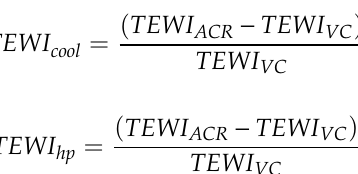
Figure 4. Coefficients of performance detected in: ( a ) cooling mode ∆ p = 0.390 GPa; heat pumping mode ( b ) ∆ p = 0.390 GPa and ( c ) ∆ p = 0.273 GPa when the system employs nanofluids as HTF.